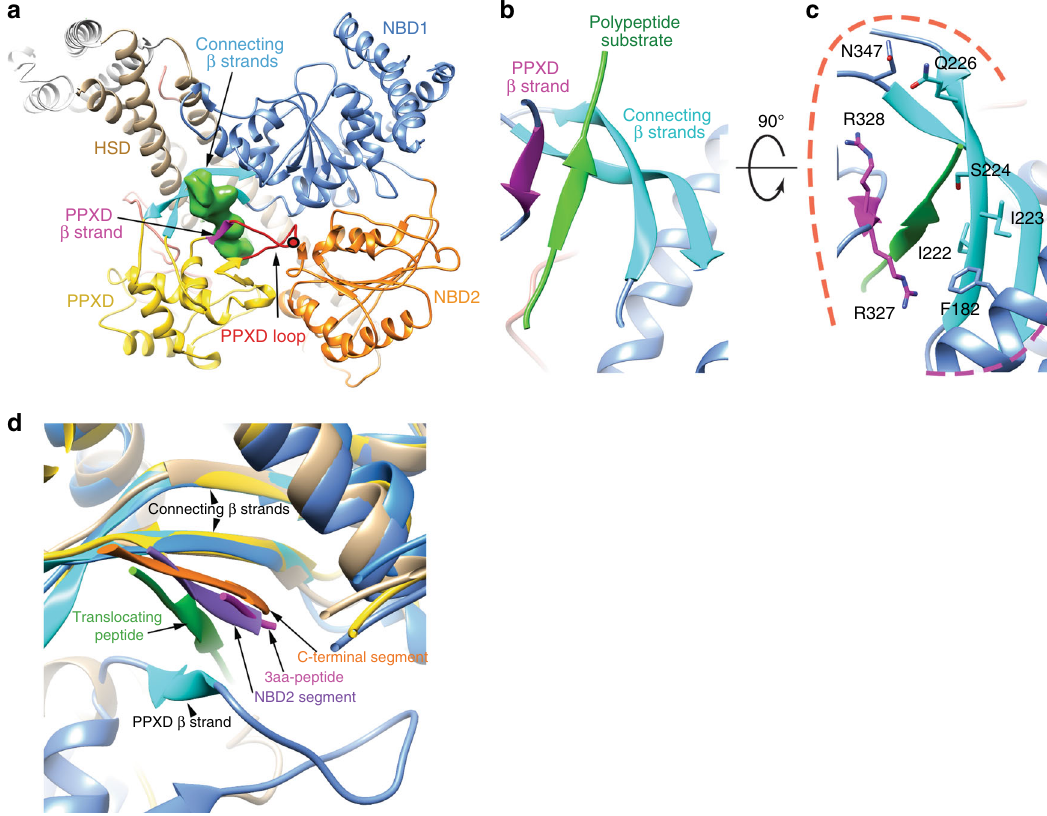
Fig. 4 Polypeptide substrate in SecA. a Top view of the SecA-SecY-substrate complex, showing polypeptide entry into SecA. The SecY channel is underneath SecA and not shown. Substrate density is shown in green. The conserved Arg367 in the PPXD loop is indicated as a red dot. b Close-up view of the β -sheet formed by substrate binding. The connecting β -strands at the back of the clamp are in shown in cyan, the PPXD β -strand in magenta, and the β - strand formed by the substrate in green. c SecA residues surrounding the polypeptide substrate are shown as sticks. Hydrophilic and hydrophobic residues, clustered on different sides, are highlighted with orange and purple dashed curves. d Interaction of the connecting β strands with different peptides. Shown is a superposition of different structures, in which β -strands were induced. The alignment is based on the connecting β -strands. The peptides are derived from (1) the translocating peptide in the present structure (green); (2) a C-terminal SecA segment (orange, PDB 1M74); (3) three amino acids of a synthetic peptide (red, PDB 3JV2); and (4) a segment of NBD2 of a neighboring SecA molecule in the crystal (purple, PDB